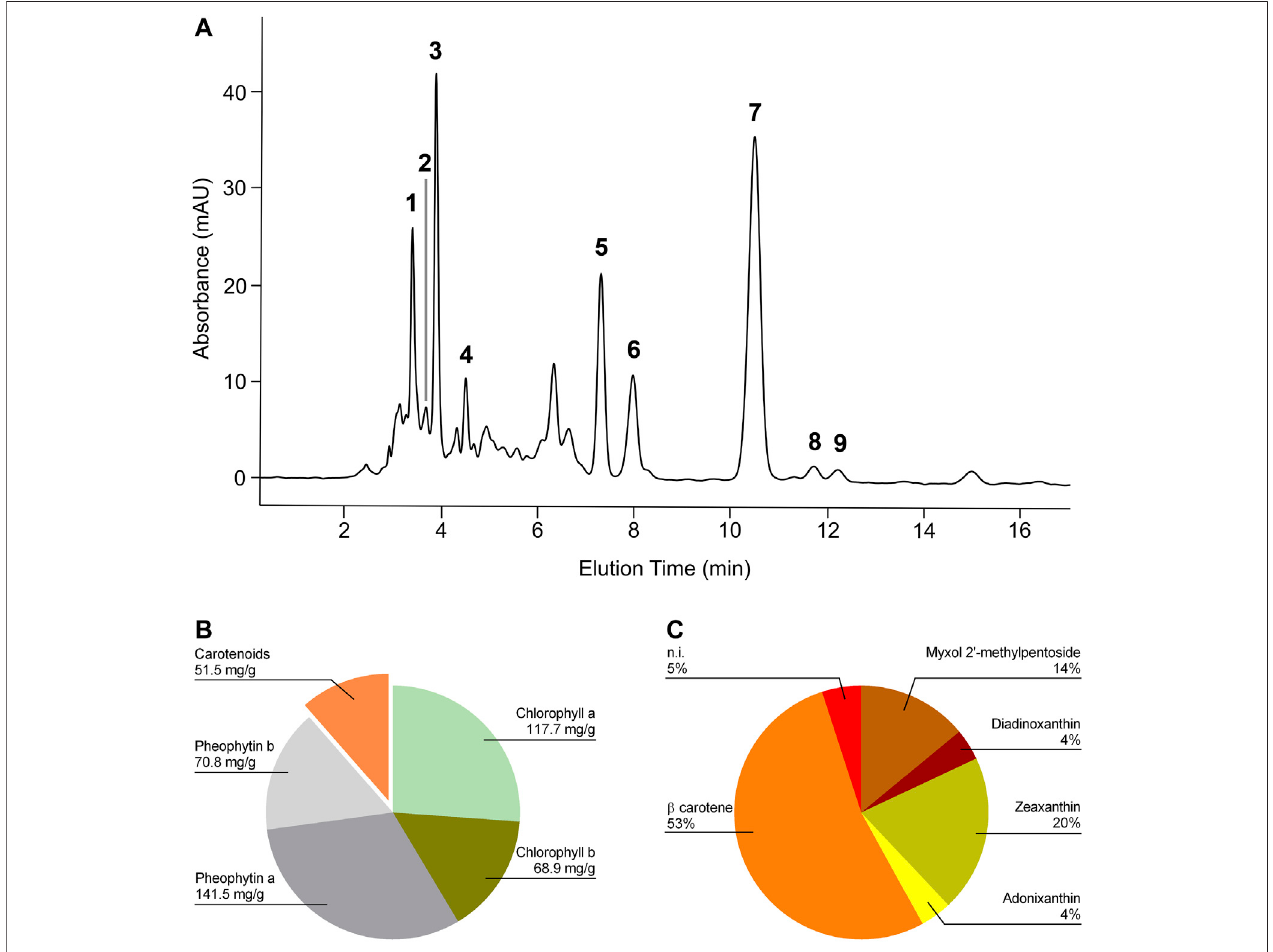
FIGURE 1 | HPLC pro fi le of the Spirulina acetone extract and its relative composition. (A) Chromatogram was registered at 460 nm. Retention times: myxol 2 ′ - methyl pentoside, 3.45 min (1); diadinoxanthin, 3.72 min (2); zeaxanthin, 3.94 min (3); adonixanthin, 4.5 min (4); unidenti fi ed xanthophylls, 3.18, 4.36, and 4.98 min; chlorophyll a, 7.35 min (5); chlorophyll b, 8.01 min (6); β carotene, 10.5 min (7); pheophytin a, 11.76 min (8); pheophytin b, 12.25 min (9). (B) Content of chlorophyll a, chlorophyll b, pheophytin a, pheophytin b, and total carotenoids expressed as mg/g of dry extract. (C) Relative carotenoid content in E1. β -carotene represented 53% of total carotenoids